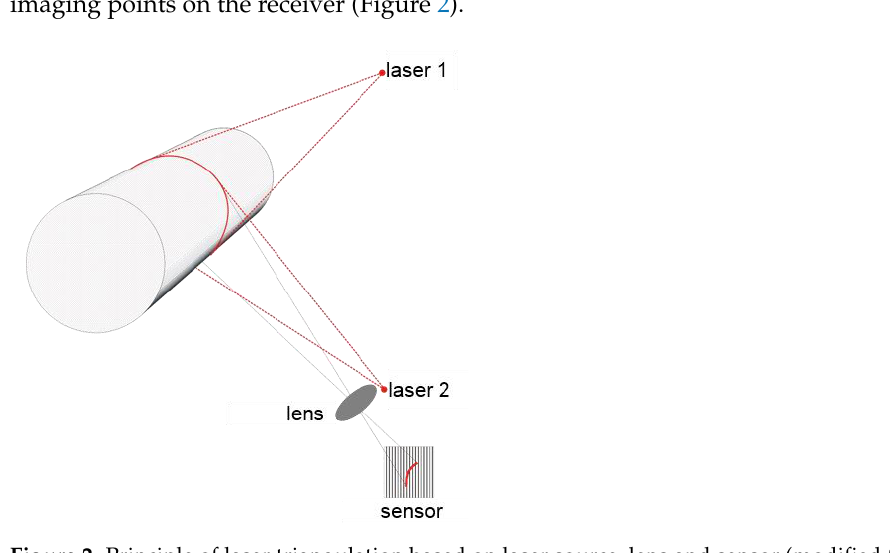
Figure 2. Principle of laser triangulation based on laser source, lens and sensor (modified from [13]).